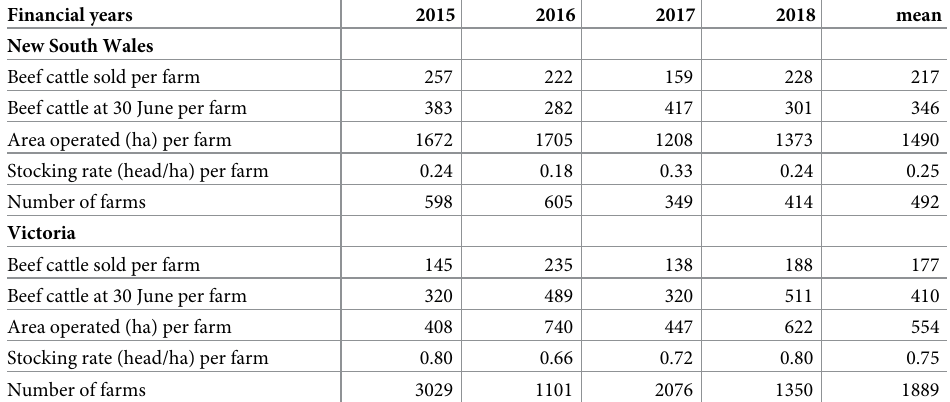
Table 2. Characteristics of NSW and Victorian beef cattle farms in the southern sheep-wheat belt of south-eastern